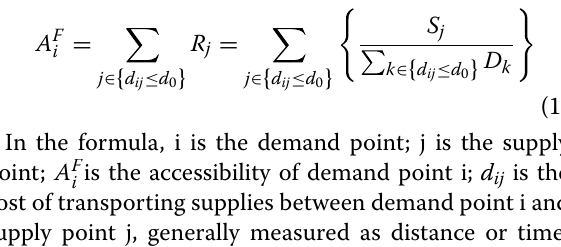
division and traffic network data are from OpenStreet- Map, based on which the Xi’an road topological net- work with the network path topological relationship is established.